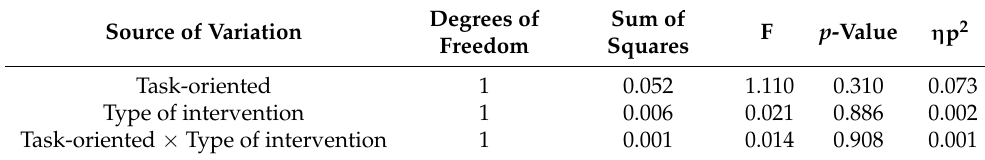
Table 6. Analysis of variance for dependent variable “task-oriented motivational climate”. Degrees of Sum of F p -Value η p 2 Source of Variation Freedom Squares Task-oriented 1 0.052 1.110 0.310 0.073 Type of intervention 1 0.006 0.021 0.886 0.002 Task-oriented × Type of intervention 1 0.001 0.014 0.908 0.001